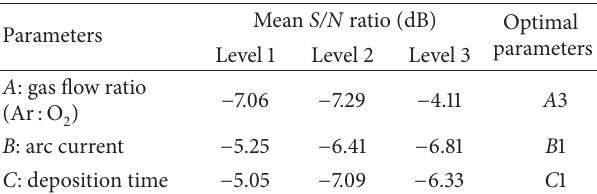
Table 5: S/N response for grey-relational grade.